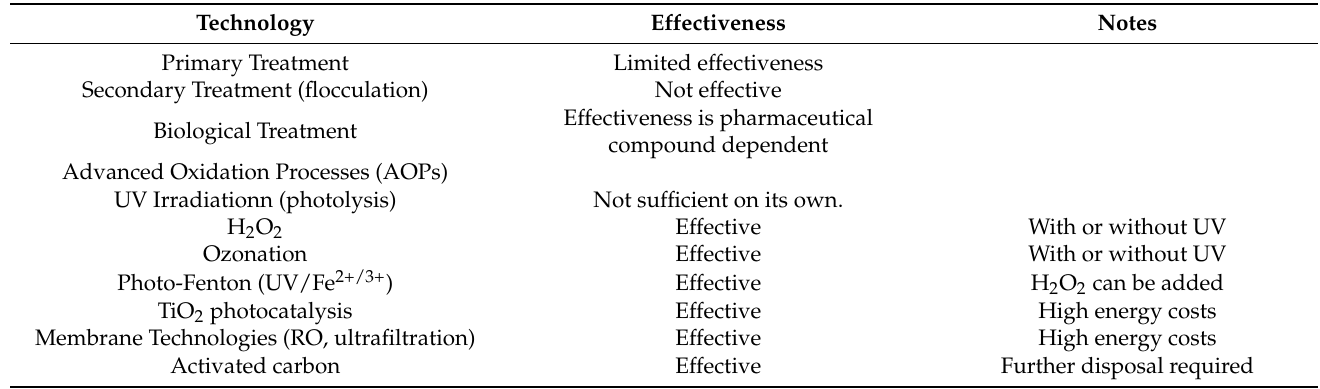
Table 1. A summary of typically assessed technologies and their